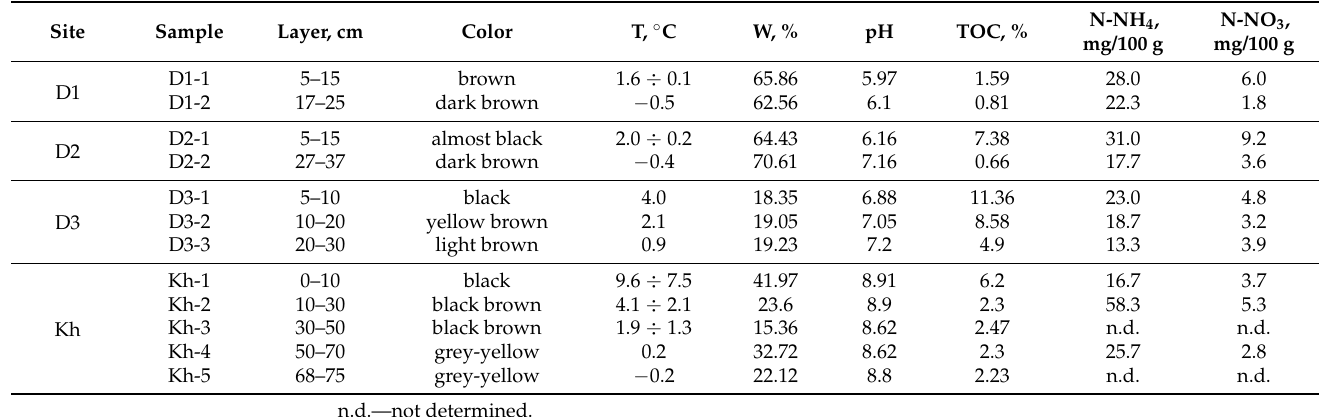
Table 2. Soil physicochemical characterization.